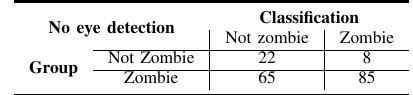
TABLE II: FACE RECOGNITION RESULTS WITHOUT EYE DE- TECTION.